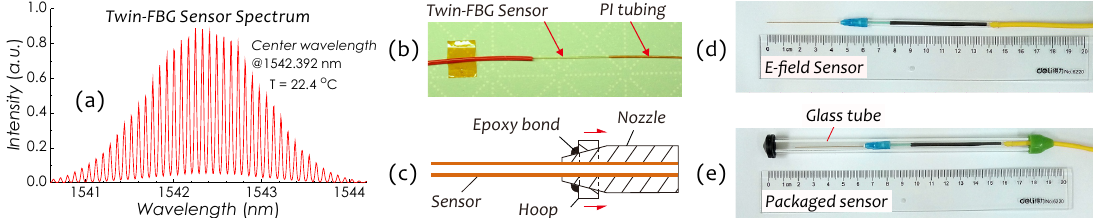
Figure 4. ( a ) Spectrum of a twin-FBG sensor; ( b ) a photo of twin-FBG sensor and PI tubing; ( c ) a schematic on parts assembly; ( d ) a photo of E -field sensor; and ( e ) a photo of packaged